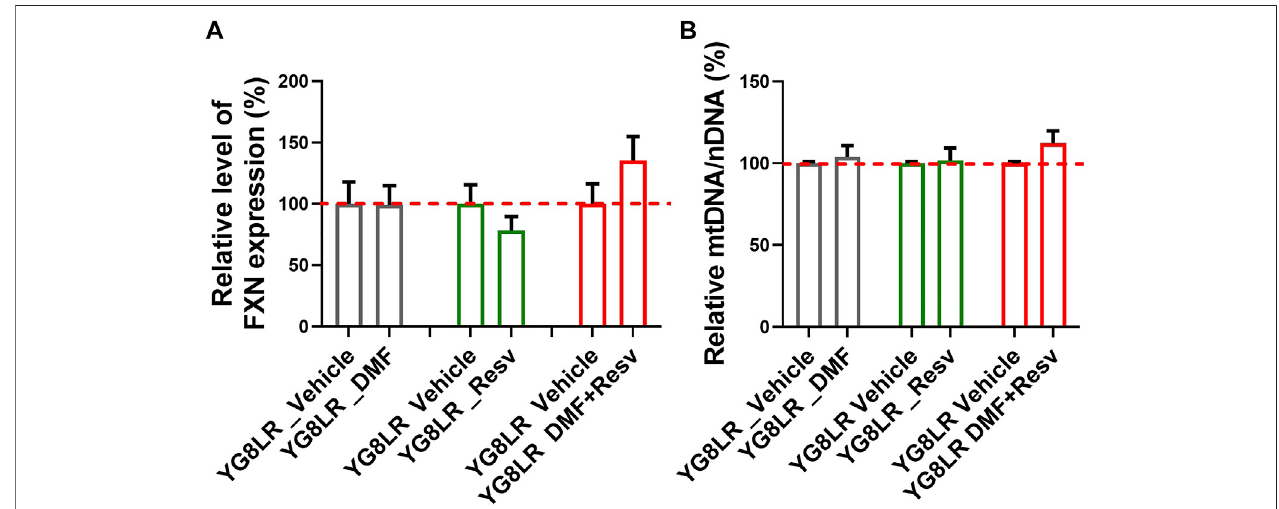
FIGURE 4 | Short-term study in YG8LR mice. (A – B) The histogram represents the FXN mRNA expression and mtDNA/nDNA in brain of mice treated for 5 days with either vehicle (DMSO) or the compounds: (1) 10 mg/kg/d DMF; (2) 10 mg/kg/d Resv, or (3) 10 mg/kg/d DMF and 10 mg/kg/d Resv combined. Results were comparedtoYG8LRvehicle-treatedmice(mean±SD;relativelevelsof FXN %,YG8LR_DMF99.1±15.7,YG8LR_Resv78.4±11.4,YG8LR_DMF+Resv135.3±19.8, and relative mtDNA/nDNA %, YG8LR_DMF 103.98 ± 6.97, YG8LR_Resv 101.51 ± 7.8, YG8LR_DMF + Resv 112.25 ±